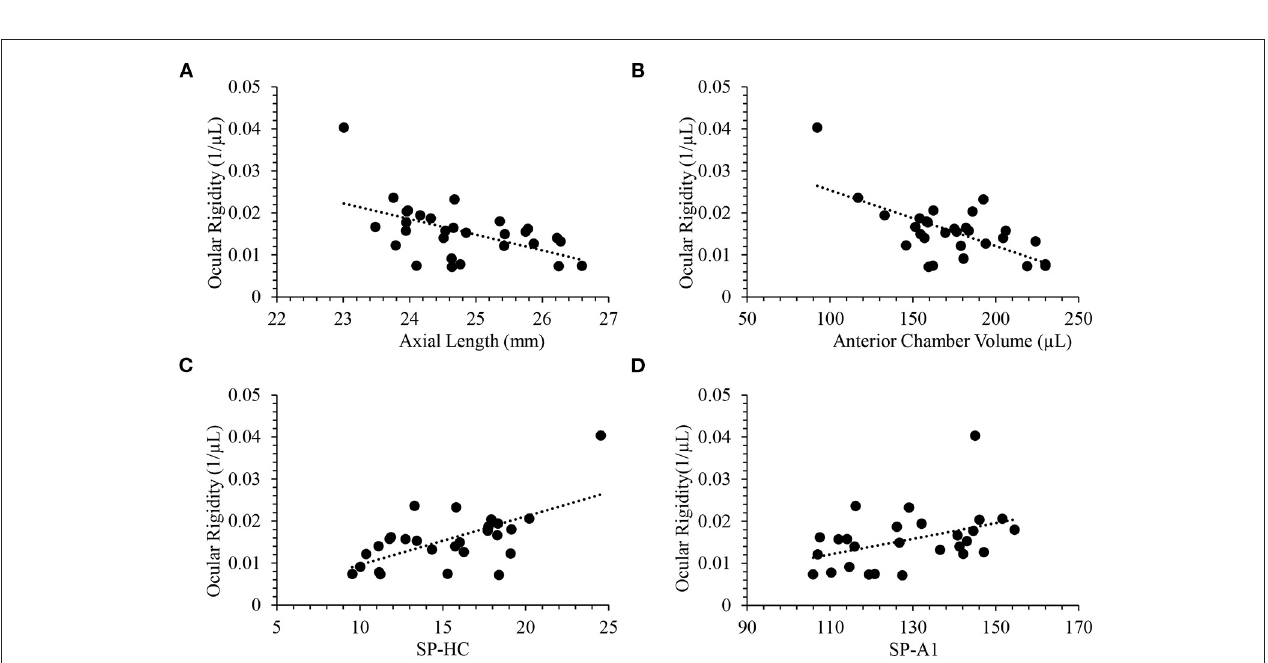
FIGURE 3 | Ocular rigidity was negatively correlated with (A) axial length ( R = − 0.53; p = 0.003) and (B) anterior chamber volume ( R = − 0.64; p = 0.0002). Ocular rigidity was positively correlated with (C) SP-HC ( R = 0.62; p = 0.0005) and (D) SP-A1 ( R = 0.41; p = 0.033).